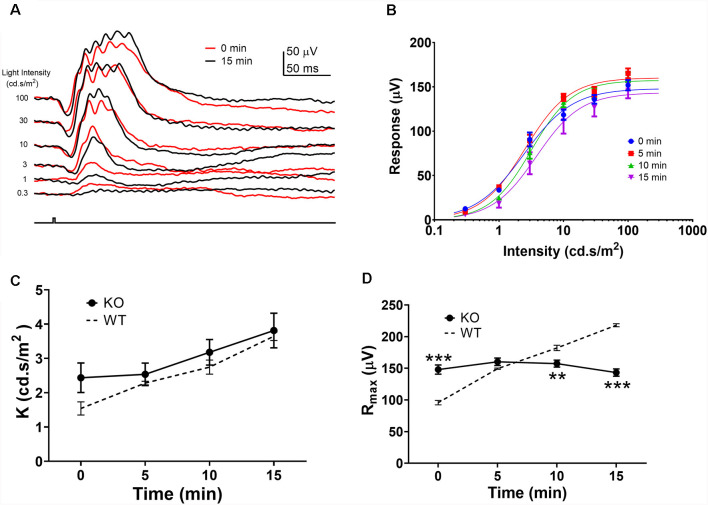
Effects of light adaptation on photopic ERG responses from Cx36ko mice. (A) Examples of the photopic ERG waveform elicited from a Cx36ko mouse by green flashes immediately (0 min, red traces) and 15 min after the onset (black traces) of the adapting background light. (B) Averaged intensity-response relations at 0, 5, 10, and 15 min after the onset of adapting light. Data were fit with a Naka-Rushton equation, with parameters of K shown in (C) and Rmax shown in (D). Dashed lines denote data from WT mice replotted from Figure 2. **p < 0.01; ***p < 0.001.